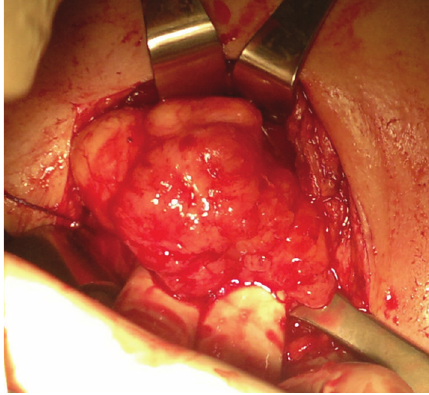
Figure 2: Intraoperative view of the bladder